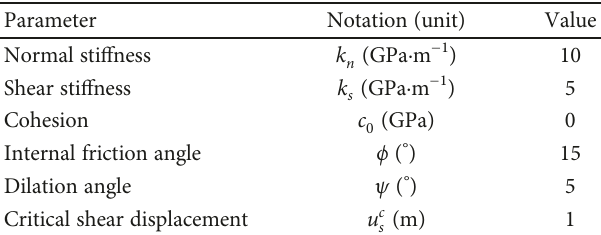
Table 2: Mechanical parameters for the fault zones. Parameter